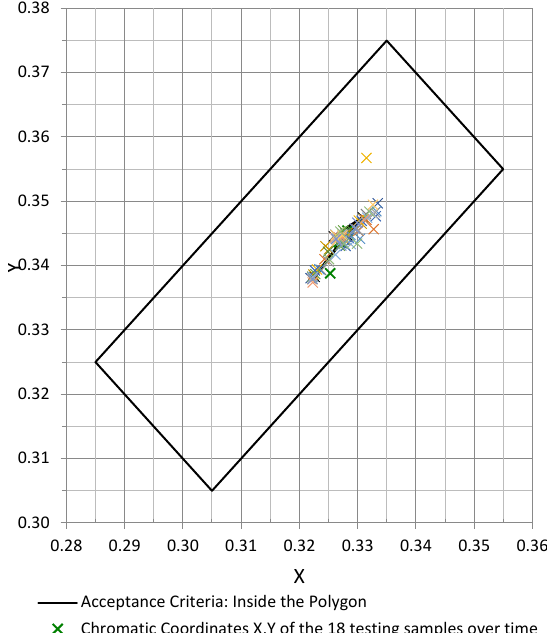
Figure 5. Surface temperature and relative humidity (RH) measured in the test section during data collection.